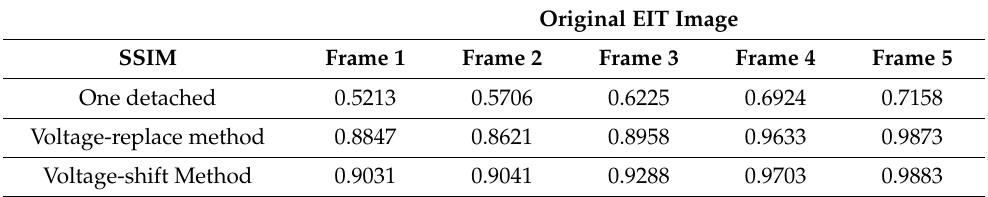
Table 3. Structural similarity index measurement (SSIM) values of all images between the original EIT lung images with well-contacted electrodes and those under the three conditions (i.e., one electrode detached, the voltage-replace method, and voltage-shift method), as shown in Figure